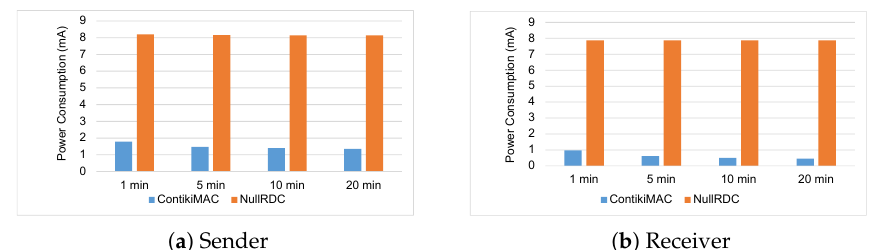
Figure 13. Power consumption of the sensor node based on third scenario.